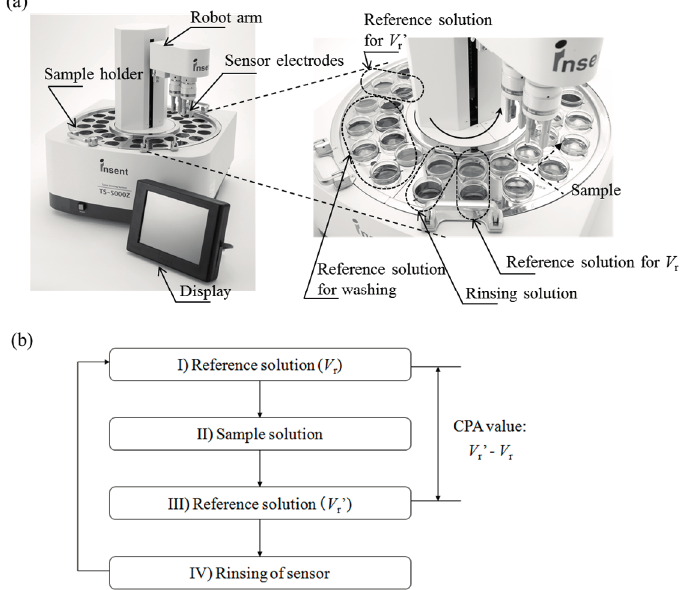
Figure 3. Schematic of the taste sensing system and CPA value measurement procedure. The TS-5000Z taste sensing system (470 mm × 530 mm × 510 mm, 26 kg) and sample holder ( a ); measurement procedure for the CPA value ( b